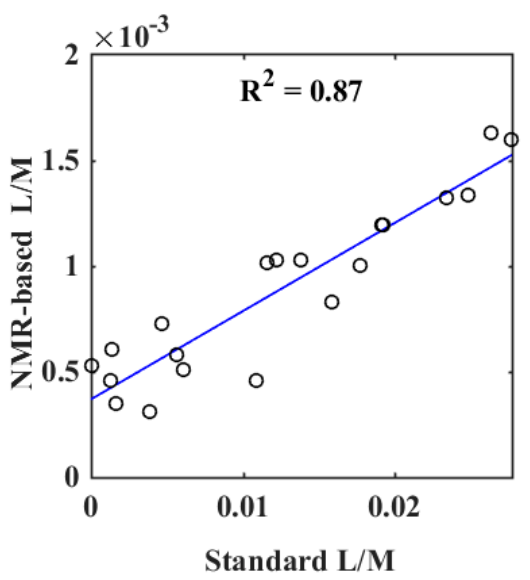
Figure 2. Results of a linear regression between the measurement of lactulose/mannitol (L/M) ratio by a standard assay and L/M ratio quantified by 1 H NMR spectroscopy.